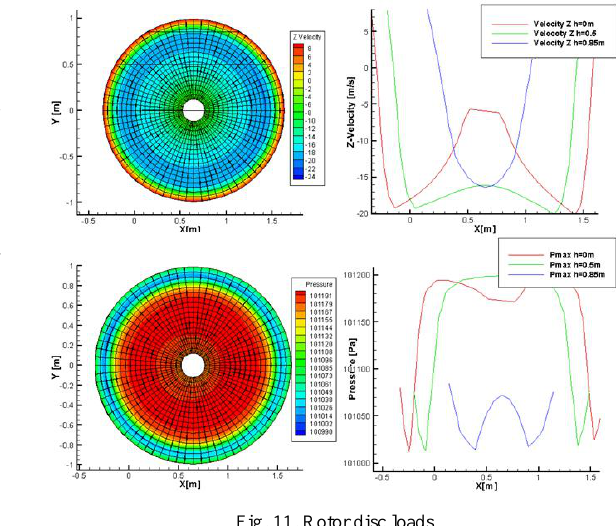
Fig. 11. Rotor disc